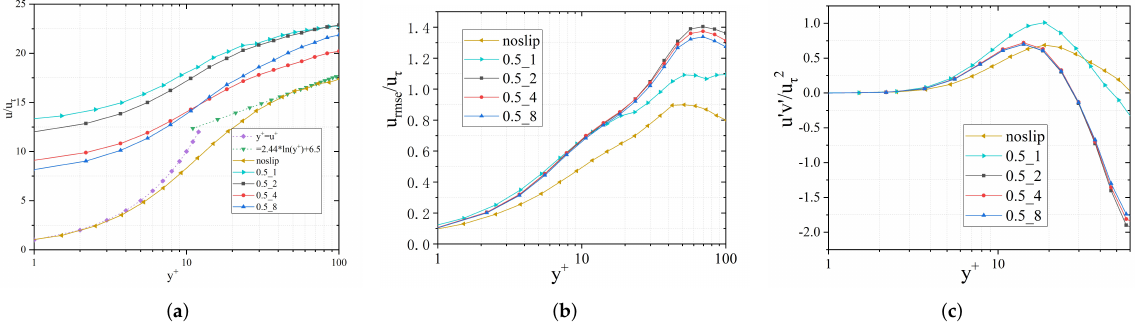
Figure 14. Comparison of statistics for GF = 0.5 and Strip number = 1,2,4,8 at the top wall of the channel (no-slip surface). ( a ) Mean streamwise velocity profile. ( b ) Velocity RMSE fluctuations. ( c ) Reynolds